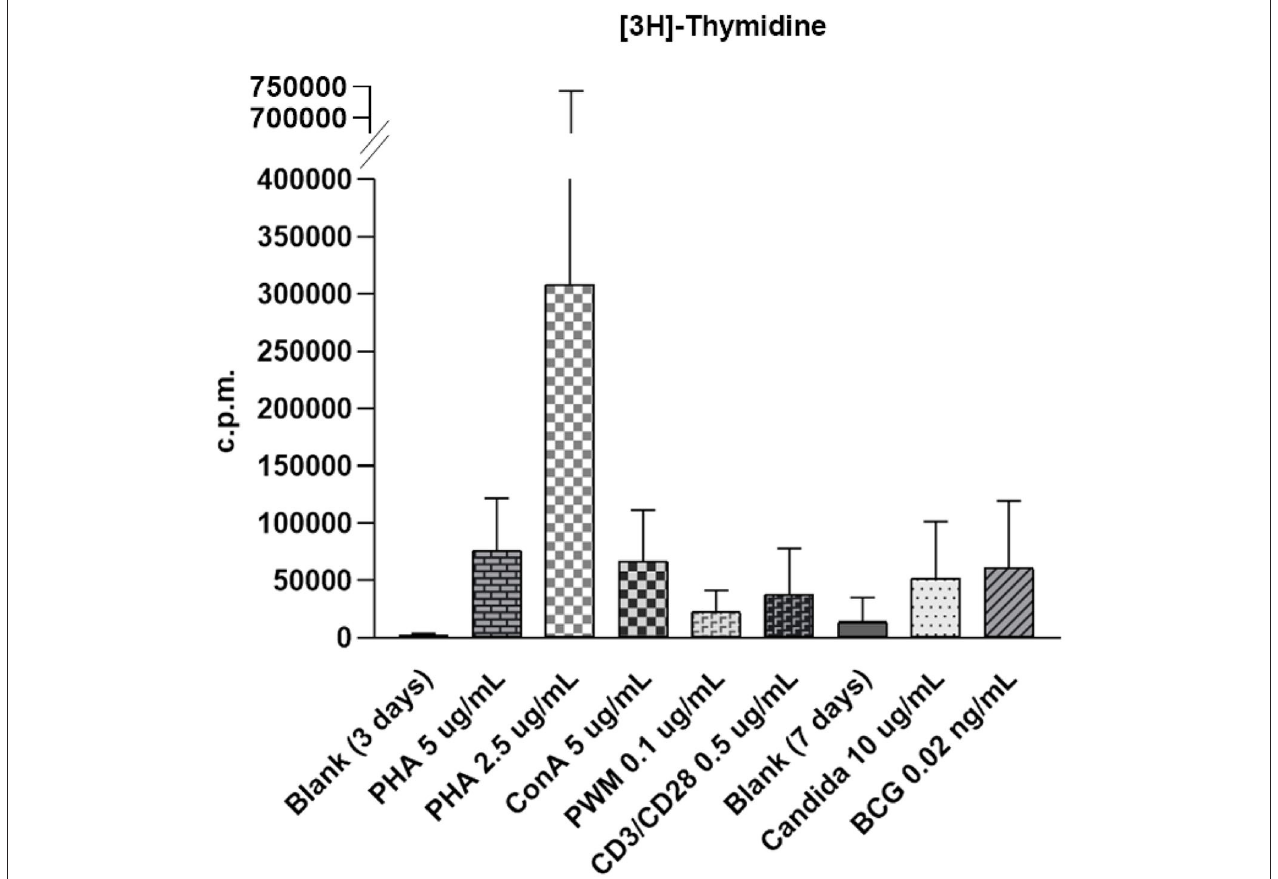
FIGURE 1 | The wide distribution of raw count per minute (c.p.m.) of [ 3 H]-thymidine incorporation in stimulated lymphocytes from 29,749 to 136,770 with phytohemagglutinin (PHA) stimulation (5 µ g/ml); 27,850 to 1638,459 with PHA stimulation (2.5 µ g/ml); 60,802 to 140,756 with concanavalin-A (ConA) stimulation (5 µ g/ml); 12,708 to 40,474 with pokeweed mitogen (PWM) stimulation (0.1 µ g/ml); 4,232 to 74,700 with CD3/CD28 stimulation (0.5 µ g/ml); 22,619 to 122,221 with candida stimulation (0.1 µ g/ml), and 10,205 to 146,730 with bacille Calmette-Guerin (BCG) stimulation (0.02ng/ml). The proliferation index for carboxyfluorescein diacetate succinimidyl ester (CSFE) staining was normalized between 2.1 and 3.0. The [ 3 H]-thymidine incorporation in unstimulated lymphocytes in blank was from 148 to 525 in 3-day culture (for mitogen comparison) and from 1,455 to 7,257 in 7 days culture (for antigen